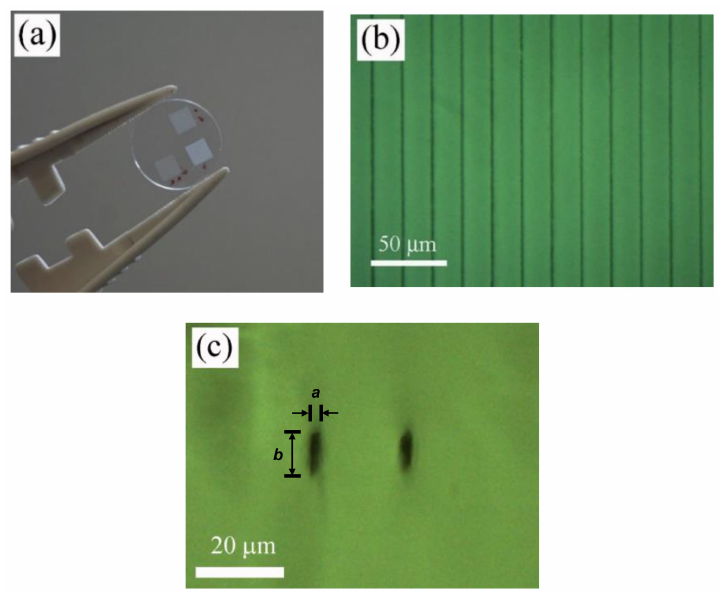
Figure 2. General view of the gratings inscribed with the laser amplifier at 796 nm, 0.50 mm / s, and inter-line spacing of 10, 20, and 40 µ m using laser pulse energy of 0.09 µ J, ( a ), and top-view and cross-section-view microscope images in bright field mode of the sample processed with 20 µ m inter-line spacing, 0.09 µ J laser pulse energy, and 0.50 mm / s scanning speed, ( b , c